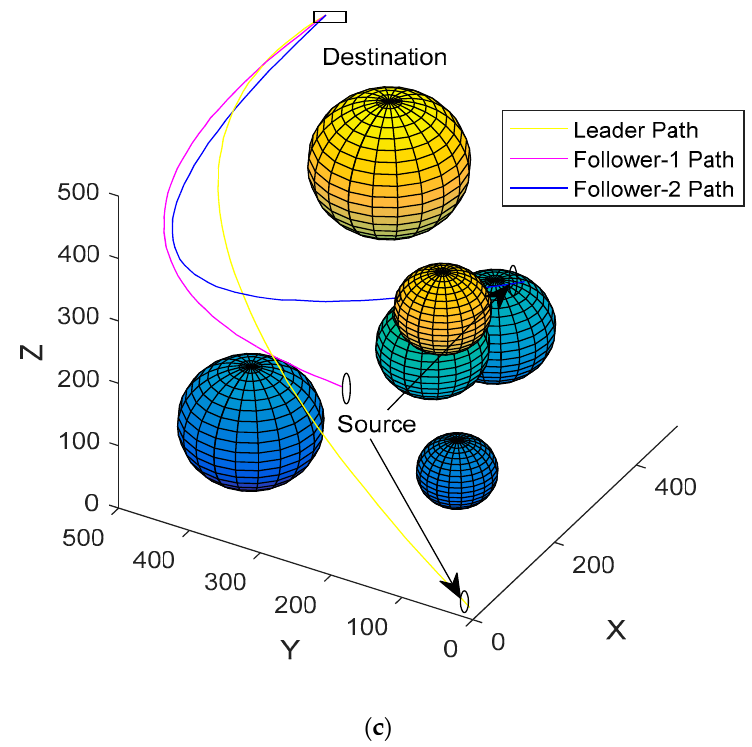
Figure 7. Optimized paths for cooperative path planning with: ( a ) GA; ( b ) GWO; ( c ) HGWO. For the leader AUV, the path distances covered are 1120.04 m, 1062.03 m and 1033.17 m and path costs are − 45.95 m, − 33.45 m, and − 19.47 m by employing the GA, GWO